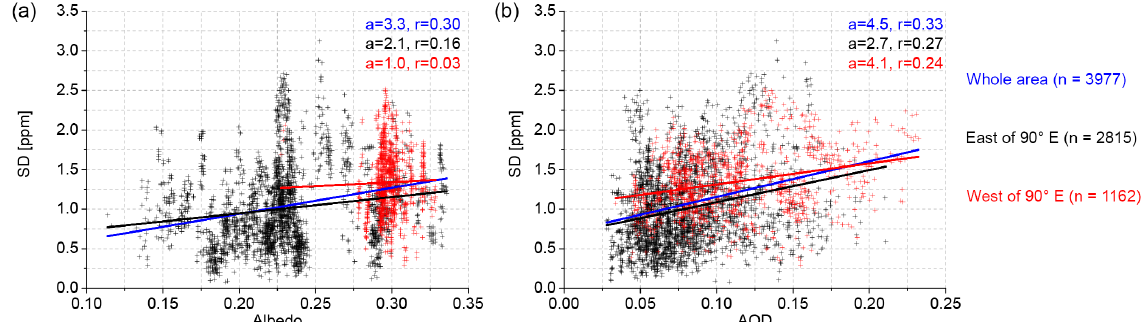
Figure 11. Scatter plots of the SD (SD) of XCO 2 from the four algorithms to albedo (a) and AOD (b) . Colored points represent different cells: red (80, 90 ◦ E), black (90, 120 ◦ E) in the latitude zone (37, 42 ◦ N). Colored solid lines display the corresponding linear regression trend line for the scatter plots with the regression slope ( a ) and the correlation coefficient ( r ) also presented; n is the number of samples. Albedo is the mean surface albedo in 0.75mum band from the three algorithms including ACOS, NIES and SRFP. AOD is the mean AOD in 0.75mum band from the four